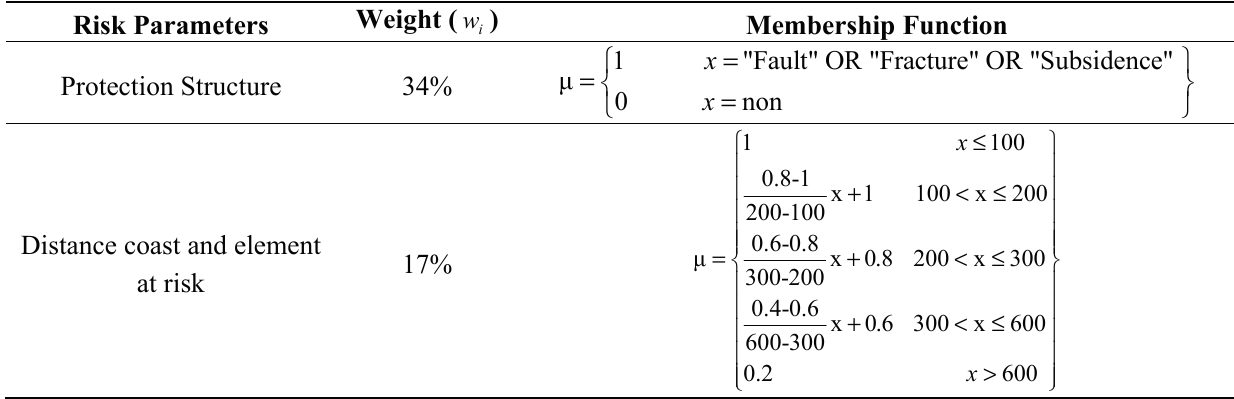
Table 5. Risk parameters, their weight and membership functions used in the case study (adapted from